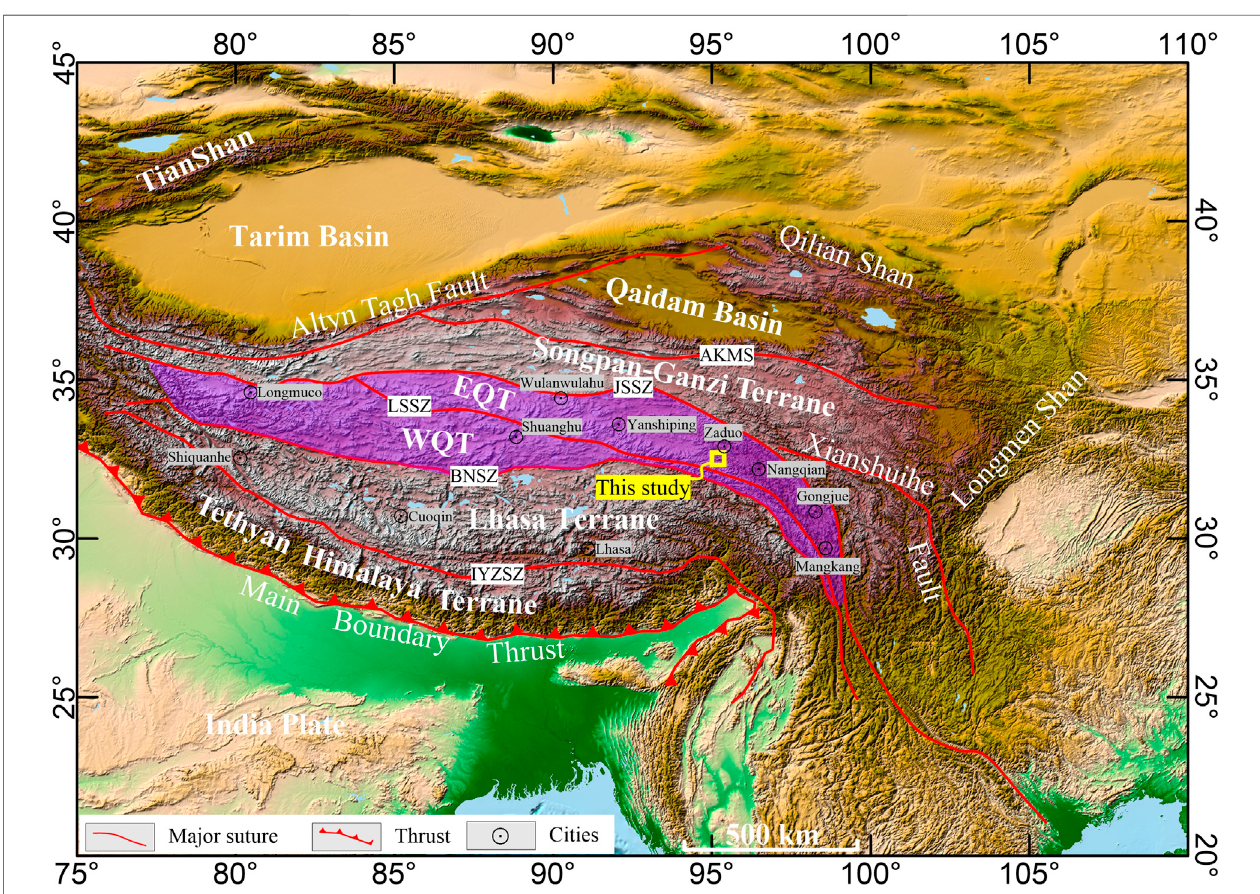
FIGURE 1 | Simpli fi ed tectonic map of the Tibetan Plateau and its adjacent regions. The abbreviations of the tectonic units are EQT: Eastern Qiangtang Terrane; WQT: Western Qiangtang Terrane; AKMS: Ayimaqing-Kunlun-Muztagh Suture Zone; JSSZ: Jinshajiang Suture Zone; LSSZ: Longmu Tso-Shuanghu Suture Zone; BNSZ: Bangong-Nujiang Suture Zone; IYZSZ: Indus-Yarlung Zangbo Suture Zone.